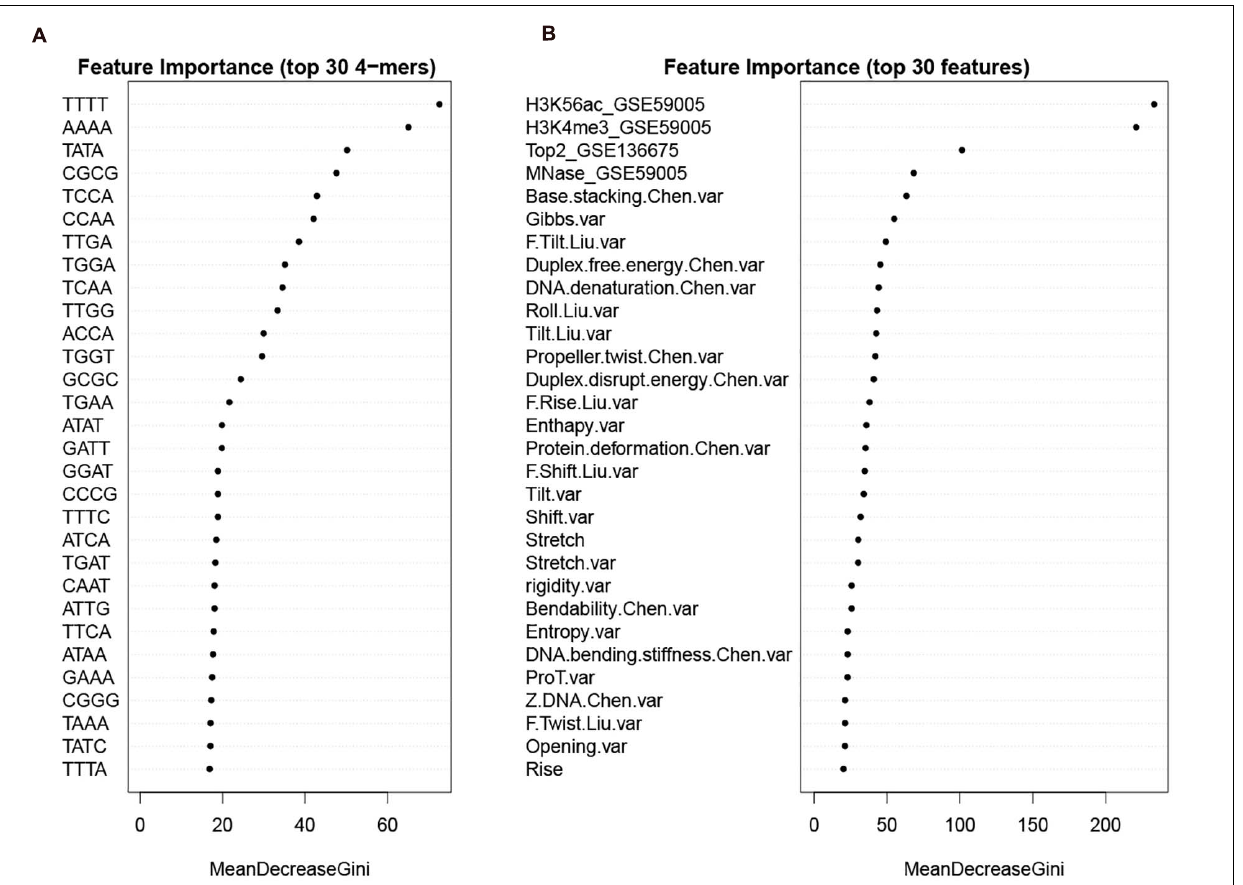
FIGURE 9 | Feature importance sorted by Gini index. (A) top 30 k-mers; (B) top 30 features selected from the whole feature set. Examples of feature name illustration: “F.Slide.Liu.var” represents the variance of force constant for slide taken from Liu et al. (2021); “Duplex.free.energy.Chen.var” represents the variance of “Duplex free energy” taken from Chen et al. (2012); “Stretch” is DNA shape parameter calculated by using DNAshapeR. See Supplementary Tables 2–4 for more details about the features.